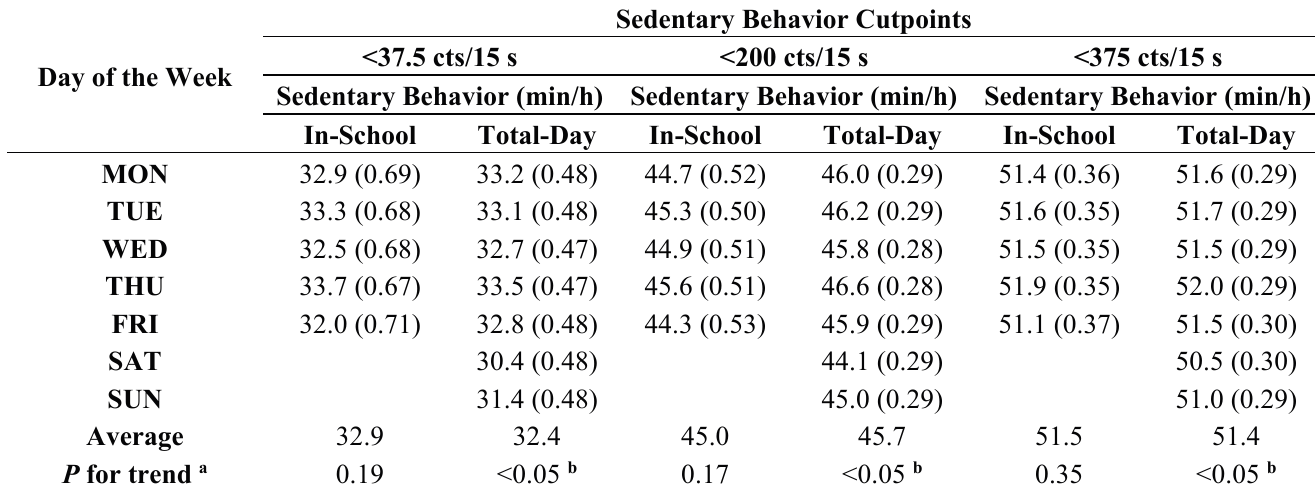
Table 3. Accelerometry-derived Time Spent in Sedentary Behavior across Days of the Week, Mean (SE).